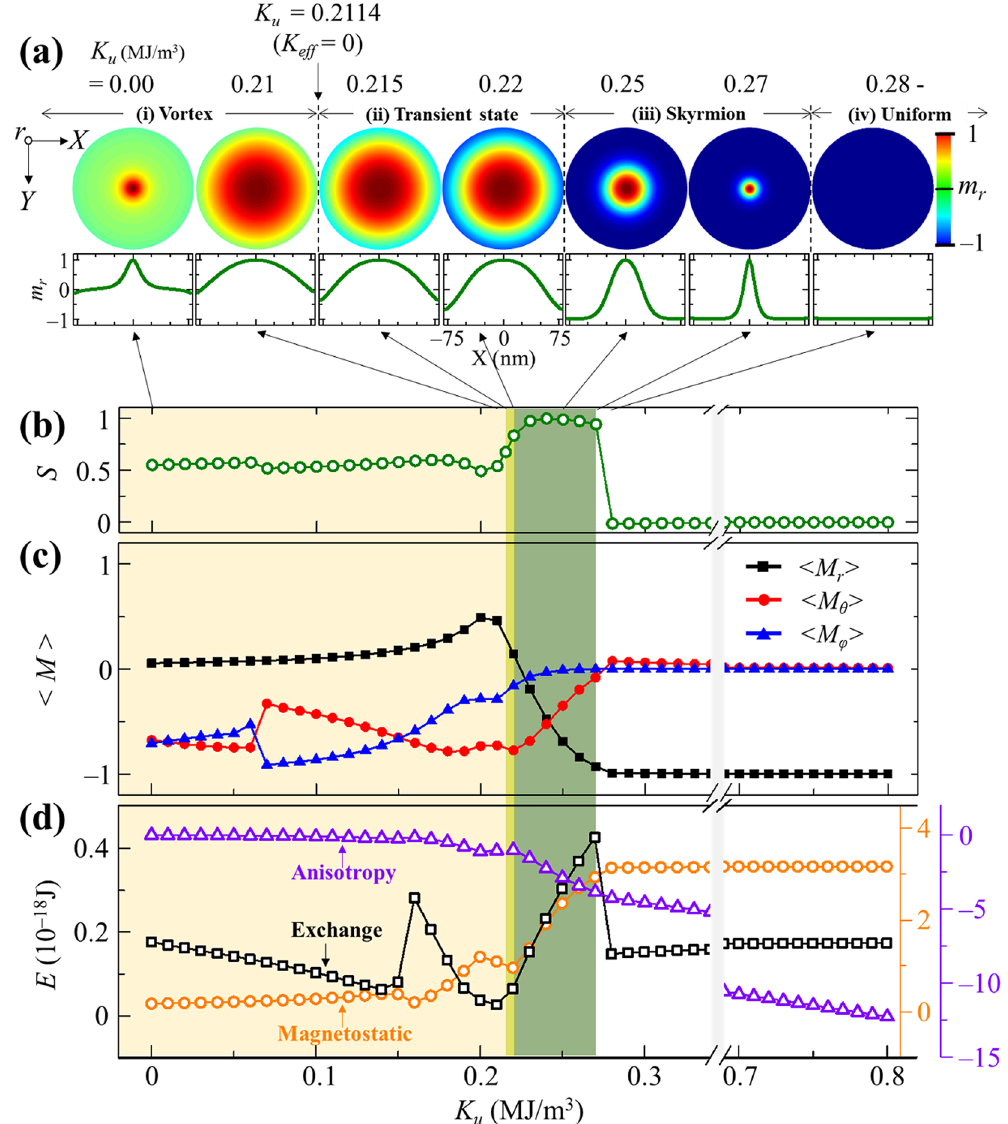
Figure 2. Variation of spin textures according to uniaxial perpendicular magnetic anisotropy (PMA) constant K u . ( a ) Unrolled-view images of spatial distributions of surface-normal magnetization component m r (= M r / M s ) of local magnetizations in corresponding ground states of hemispherical shell for 2 R = 100 nm and different values of uniaxial anisotropy K u with zero DMI constant. At the bottom, the corresponding m r line profiles across the center of the half-shells are given. There are four different types of metastable state: vortex ( K u = 0 − 0.21 MJ/m 3 ), transient state ( K u = 0.215 − 0.22), skyrmion ( K u = 0.23 − 0.27), and uniform magnetization state ( K u = 0.28 − 0.80). ( b ) Skyrmion number S and ( c ) spatially averaged magnetization components < m r >, < m θ >, and < m φ > and ( d ) exchange, magnetostatic, and anisotropy energy over entire shells as function of K u . The light yellow, orange, and green areas indicate the K u section where the vortex, the transient state, and the skyrmion can be metastable,